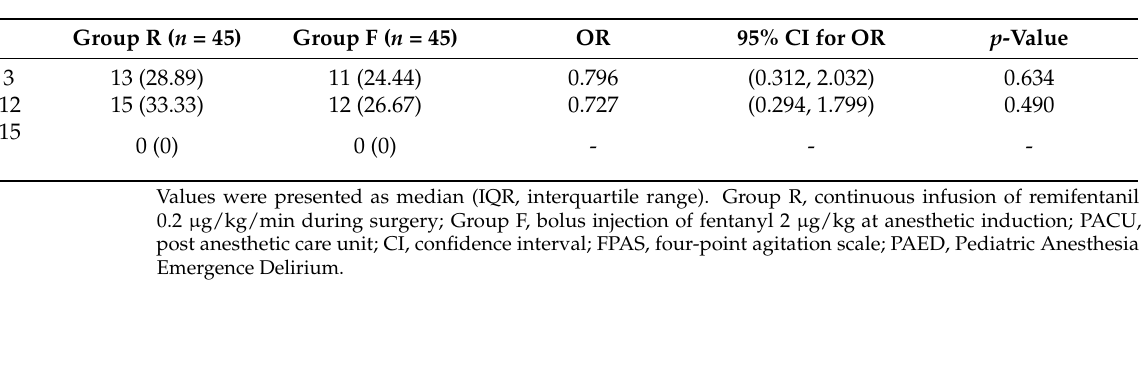
Table 3. The incidence of emergence